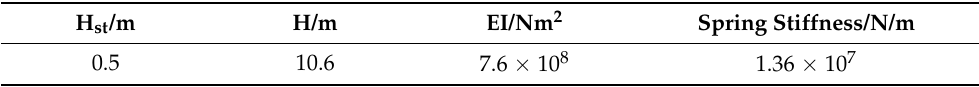
Table 4. Calculation results of beam and spring